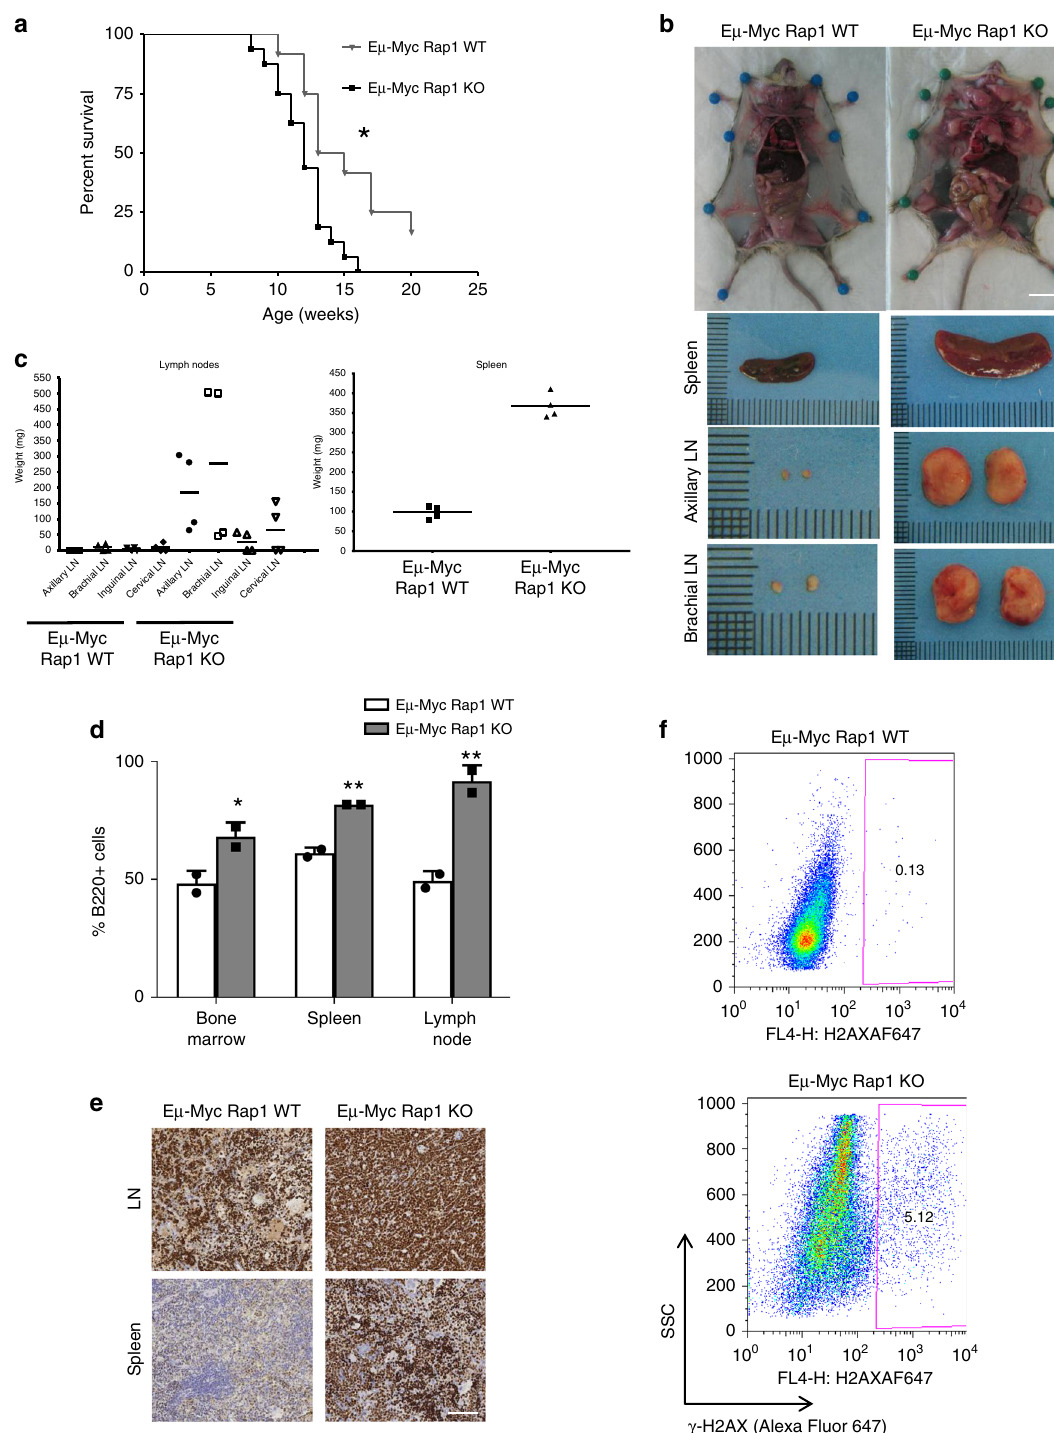
Fig. 3 Myc-induced lymphomagenesis is accelerated in the absence of Rap1. a Kaplan – Meier survival curve of E μ -Myc Rap1 WT ( n = 12) and KO ( n = 16) mice. * p value <0.05. Samples were collected after 15 weeks. b Photographs of a representative pair of E μ -Myc Rap1 WT and KO mice with enlarged LN (scale bar, 2 cm). Photos shown below are representative of spleen and LN. Samples were collected after 15 weeks. c Weights of spleen and different LN from E μ -Myc Rap1 WT and KO mice are plotted ( n = 4). d Percentage of B cells (B220 + ) derived from the bone marrow, spleen, and LN of E μ -Myc Rap1 WT and KO mice as determined by fl ow cytometry ( n = 2/genotype). Mean ± SD of the percentage of B220 + (B220 positive) cells is depicted. Samples were collected after 15 weeks. * p < 0.05 (Mann – Whitney U -test). e Immunohistochemical Ki67 staining of E μ -Myc Rap1 WT and KO LN and spleen sections. Samples were collected after 15 weeks. Scale bar, 100 μ m. f Intracellular γ -H2AX staining of B cells from spleen of E μ -Myc Rap1 WT and KO. Gated cells indicate percentage of γ -H2AX-positive cells. Samples were collected after 15